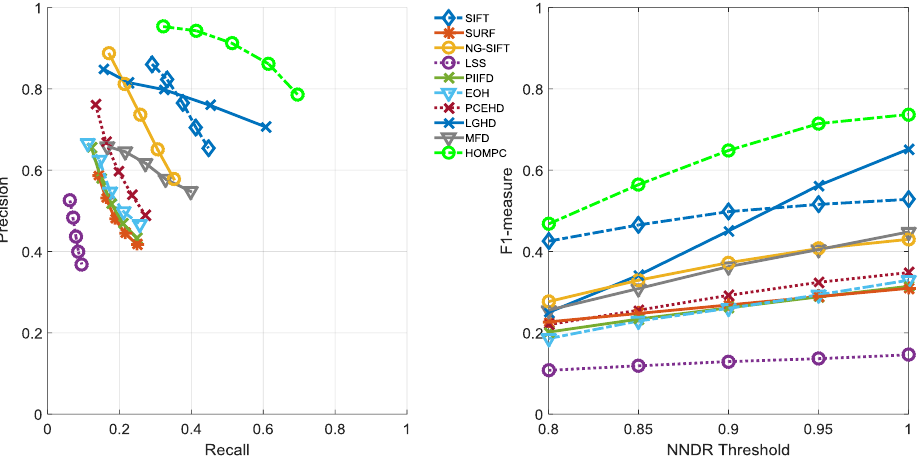
Figure 20. The average PR curves and F1-measure curve results for all the descriptors.